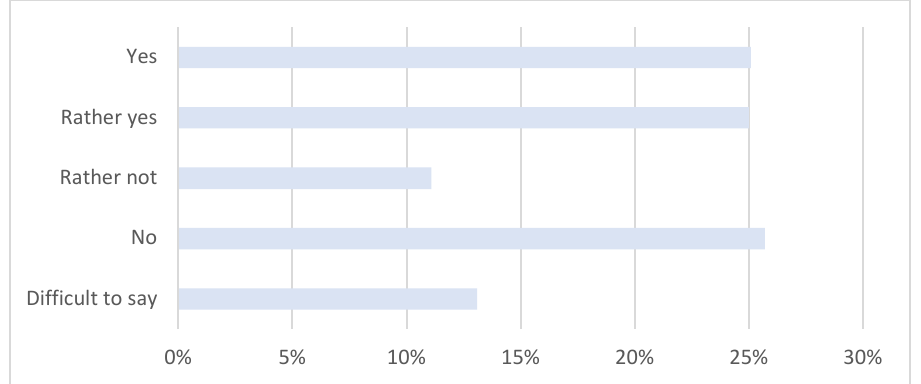
Figure 6. Interest in an internet portal featuring information regarding services available near their place of residence targeted at seniors and the disabled ( n = 521) (source, own research).